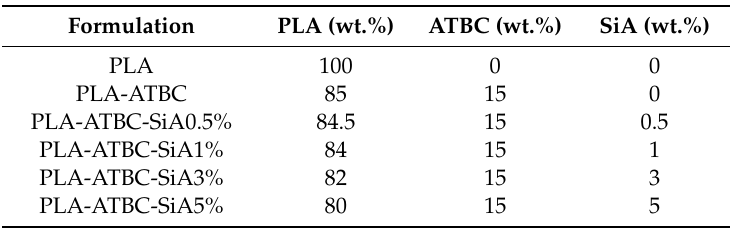
Table 1. Biocomposite film